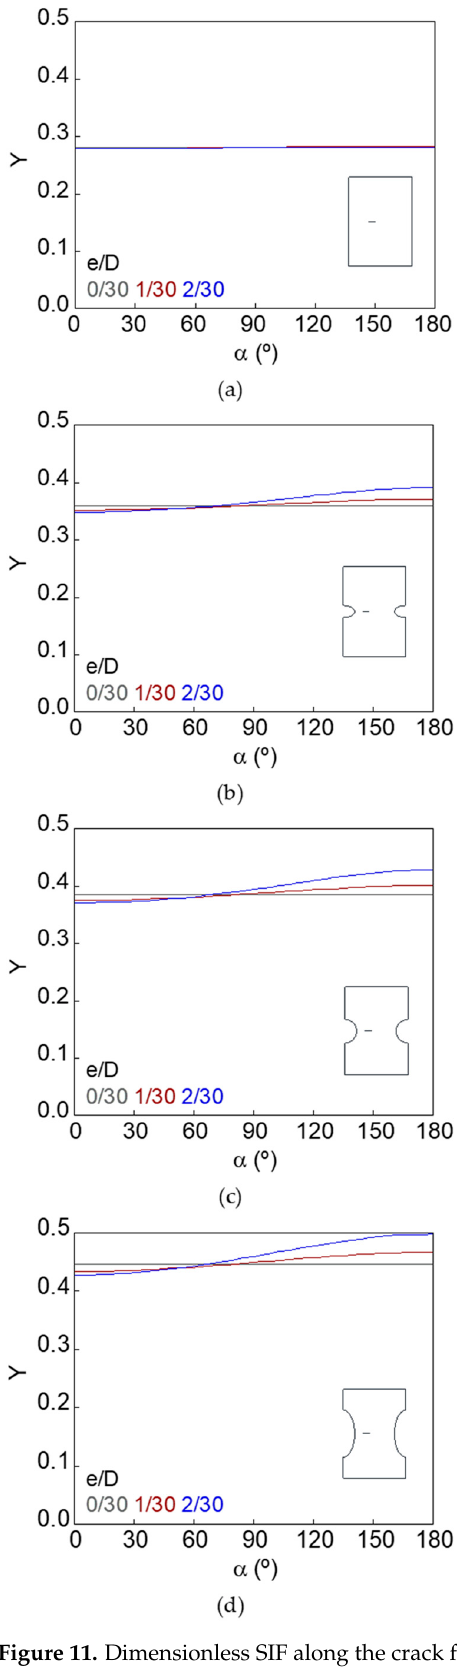
Figure 11. Dimensionless SIF along the crack front, d / D = 11/30: ( a ) smooth bar; ( b ) sharp notched bar; ( c ) circular notched bar; ( d ) blunt notched bar.